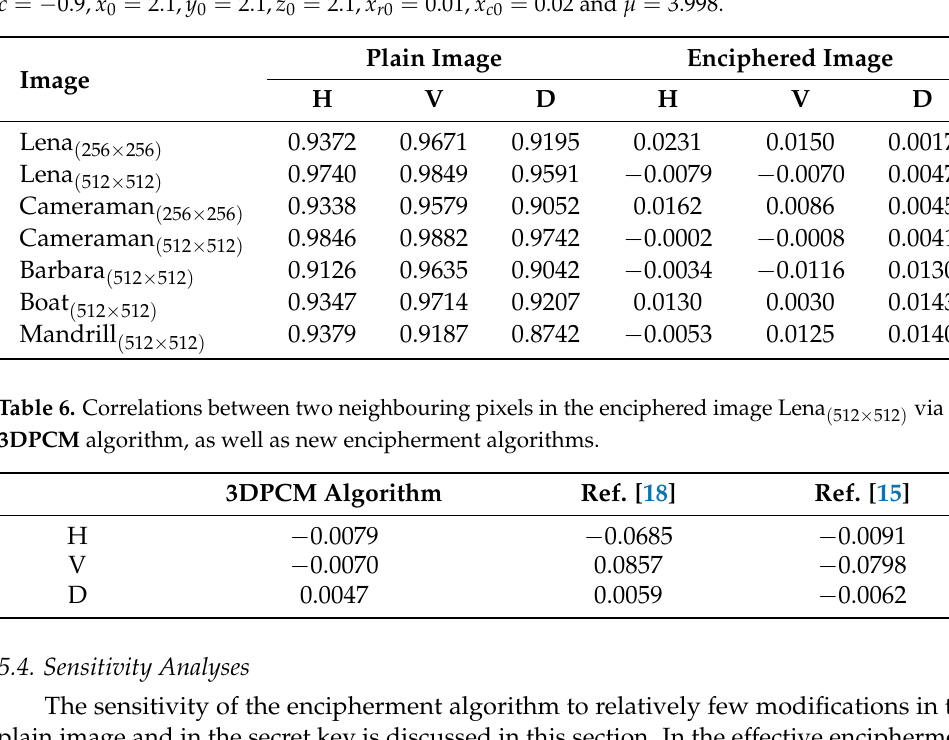
Table 5. Two neighbouring pixels Correlation of plain and enciphered image at a = 1, b =